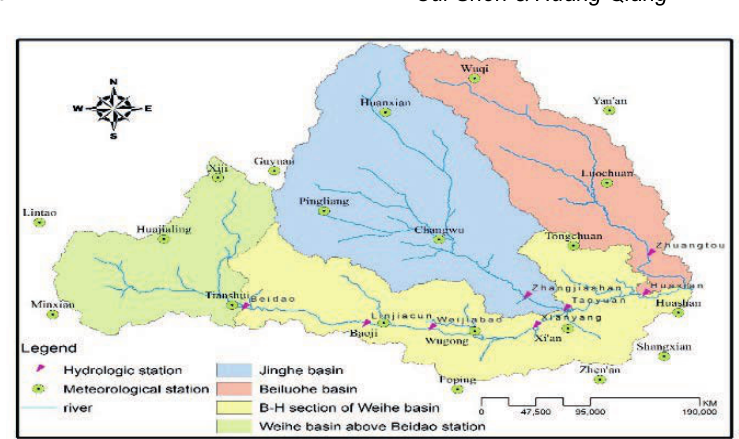
Fig. 1 The Weihe River